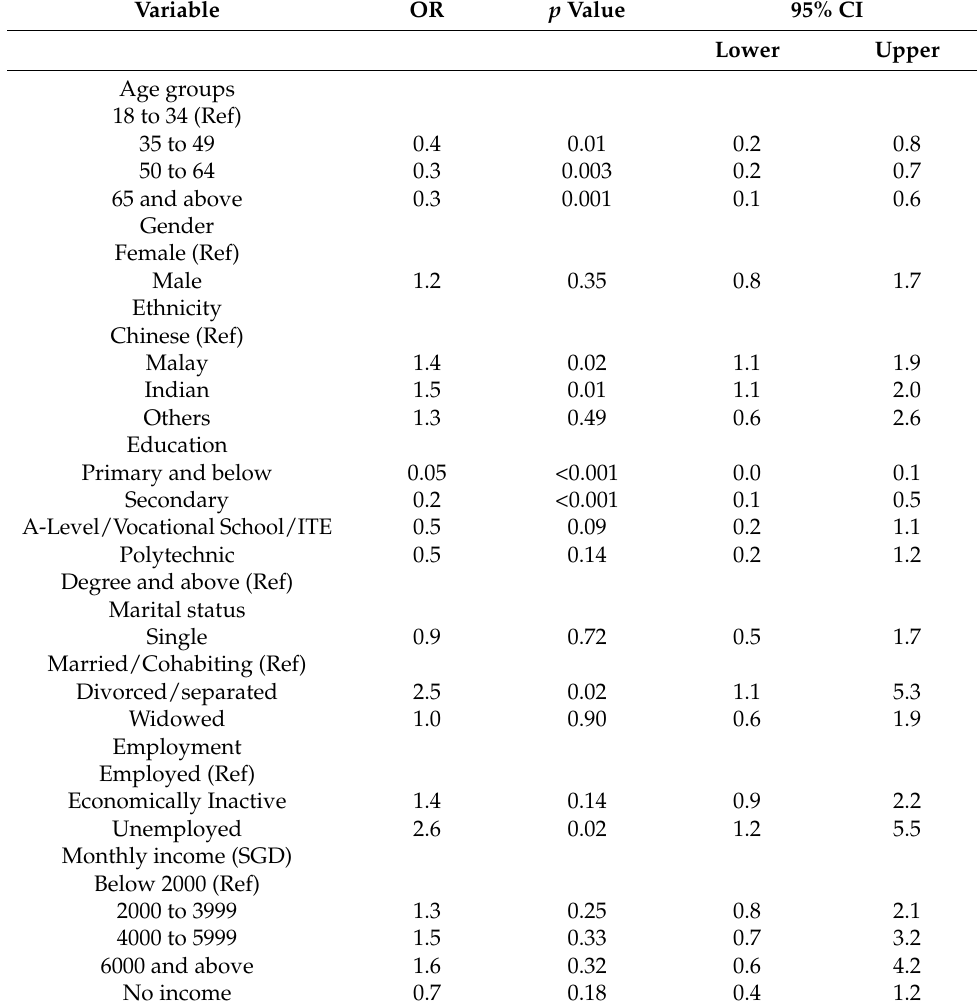
Table 2. Sociodemographic correlates of adequate